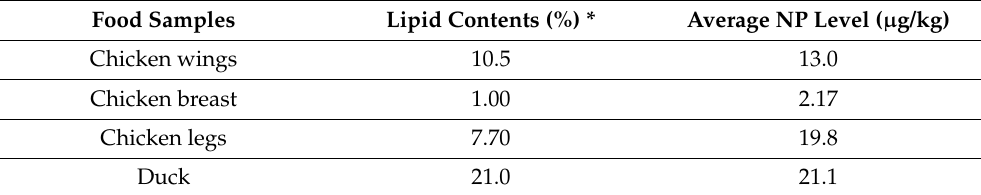
Table 5. Lipid contents and NP concentrations for chicken and duck meat.